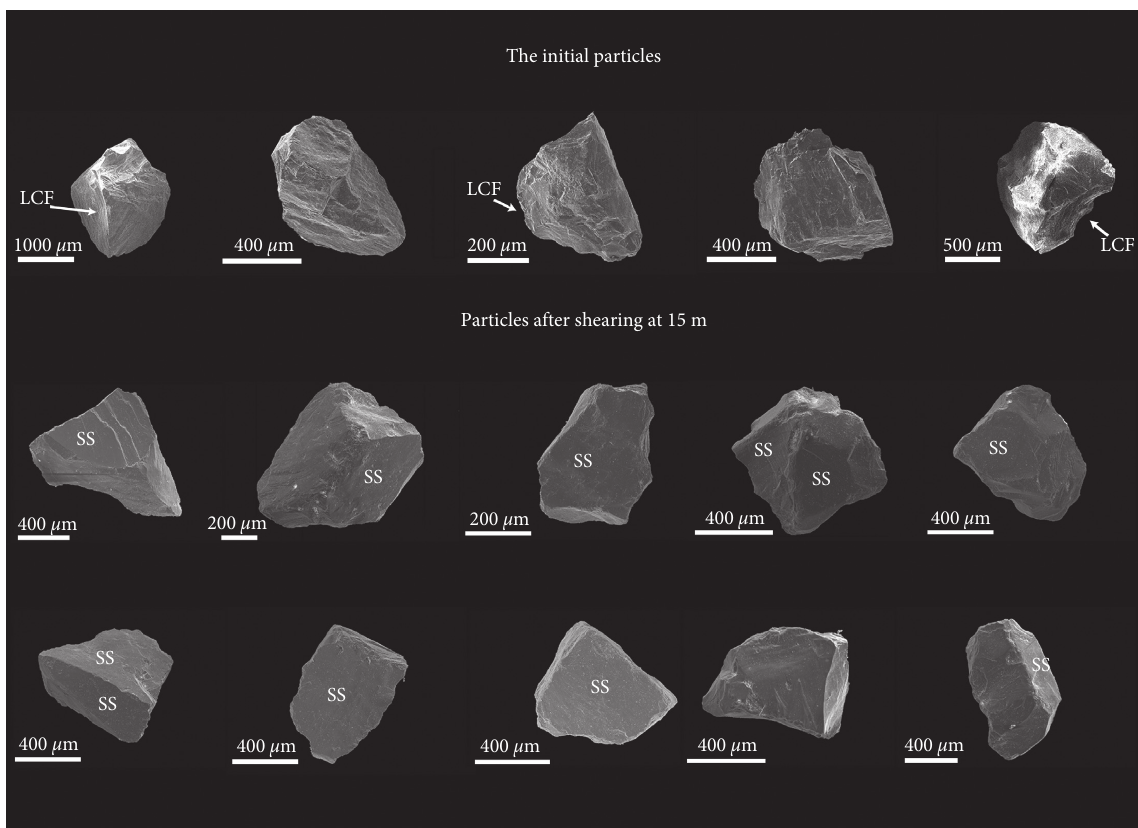
Figure 10: Scanning electron microscope images of particles for the original grain sizes and grain sizes larger than 700 µ m after shearing at 15m (SS and LCF, respectively, represent the smooth surface and large conical fracture).